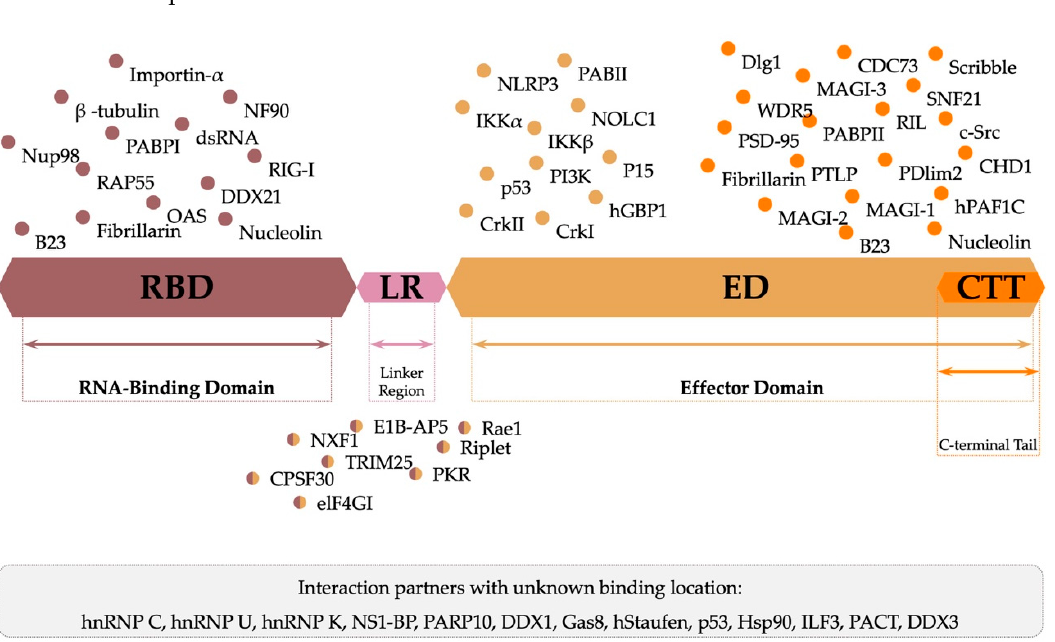
Figure 7. Graphical representation of known NS1 protein-protein and protein-RNA interactions and their respective site of interaction. (all proteins and interactions mentioned in the figure are referenced in the text).